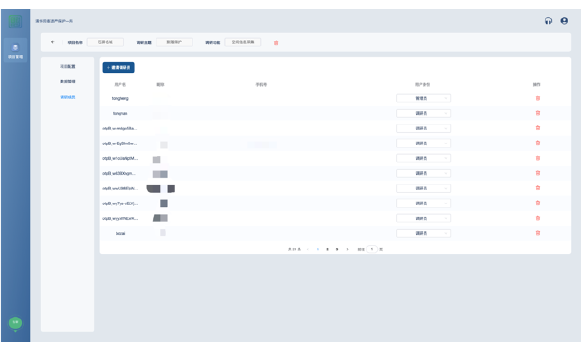
Figure 6. Collector Management Page in Backstage